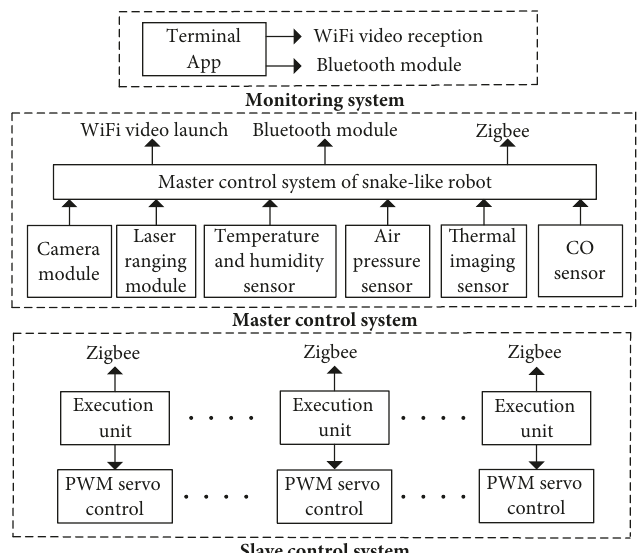
Figure 6: Design diagram of the control system.